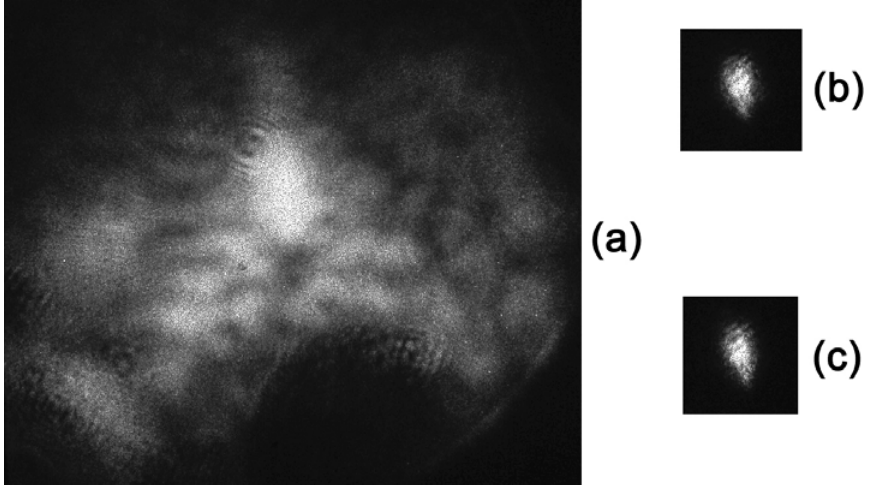
Figure 23. Results of compensation of a model phase distortion of the type of a spherical lens: ( а ) the focal distribution with a distortion of the type of a spherical lens (+1.25) and without phase conjugation; ( b ) the distribution with phase conjugation compensation of the lens, and ( c ) a phase conjugation wave without distortion. All images are given in the equal scale.